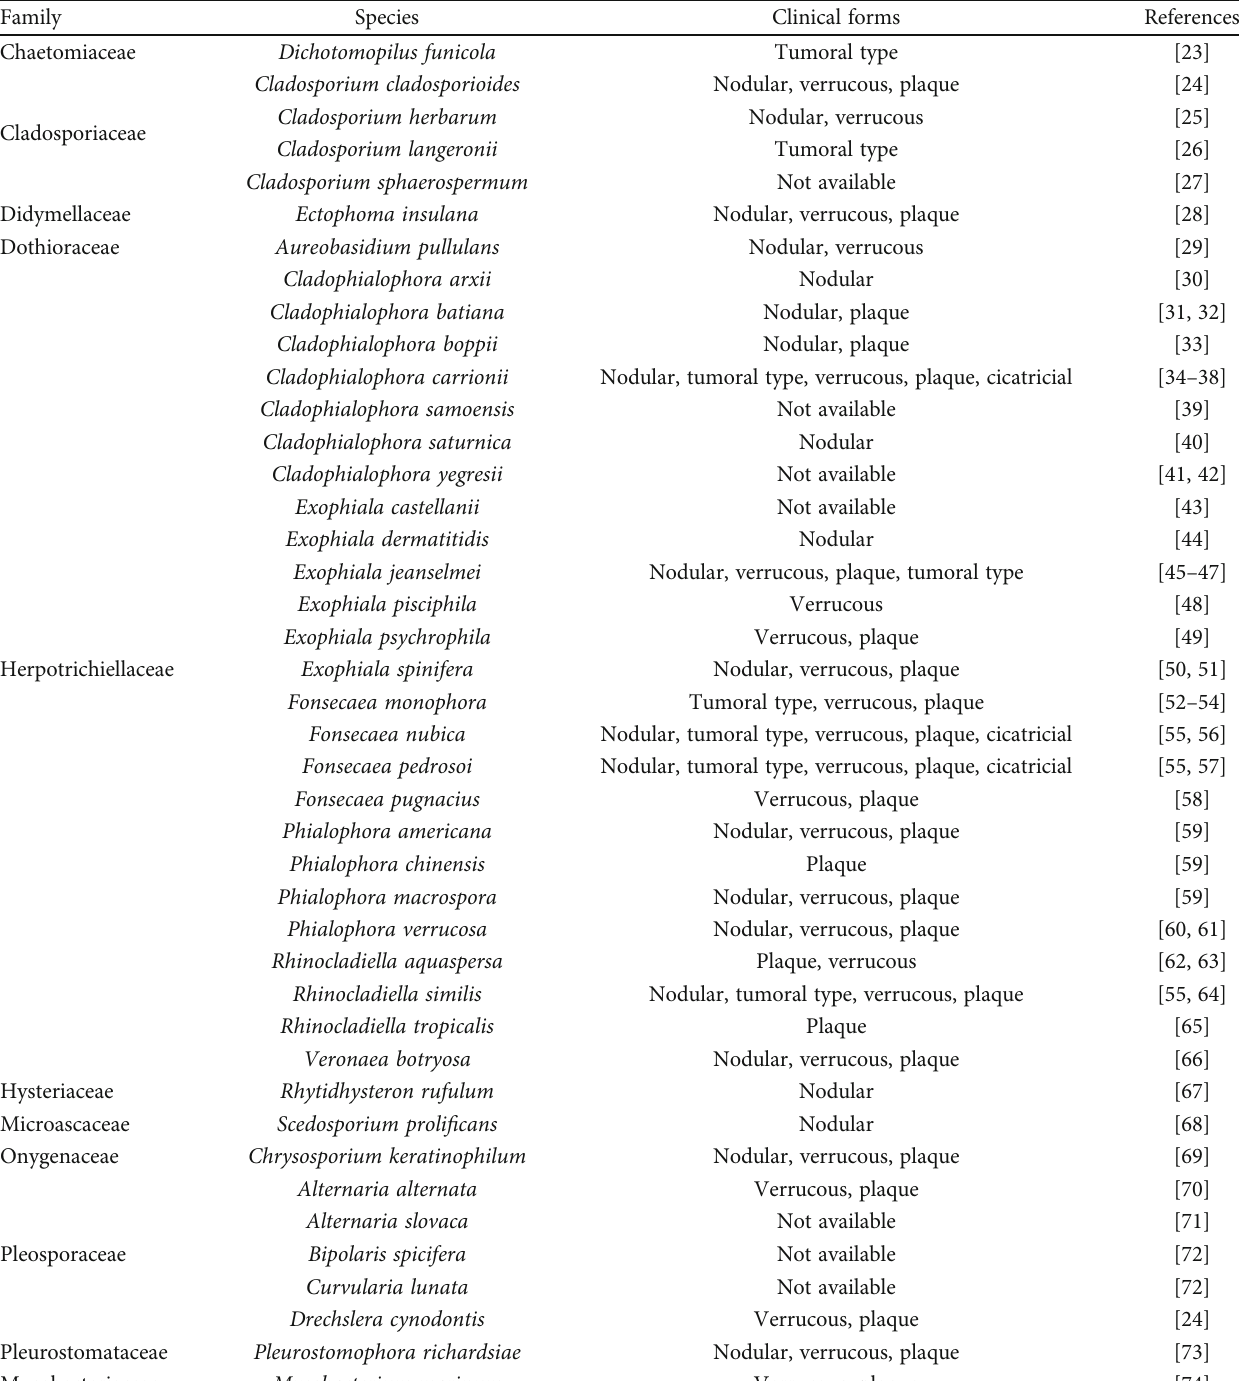
Table 1: Human CBM is caused by 41 species of fungi and one species of bacterium that are distributed into several families. All of these species cause fi ve di ff erent clinical forms of CBM. In addition, the bacteria Mycobacterium marinum (Mycobacteriaceae family) cause skin disease in humans that resembles